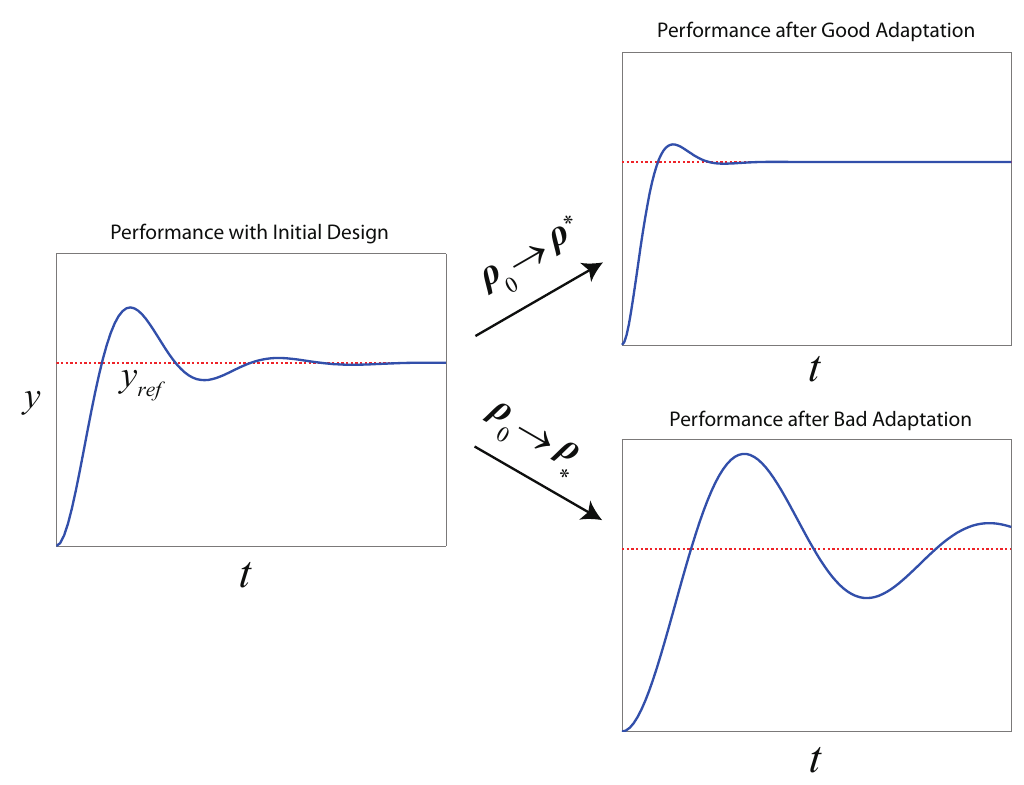
Figure 2. The basic idea of iterative controller tuning. Here, a step change in the setpoint represents the repetitive control task. We use (cid:26) might be achieved with a bad adaptation